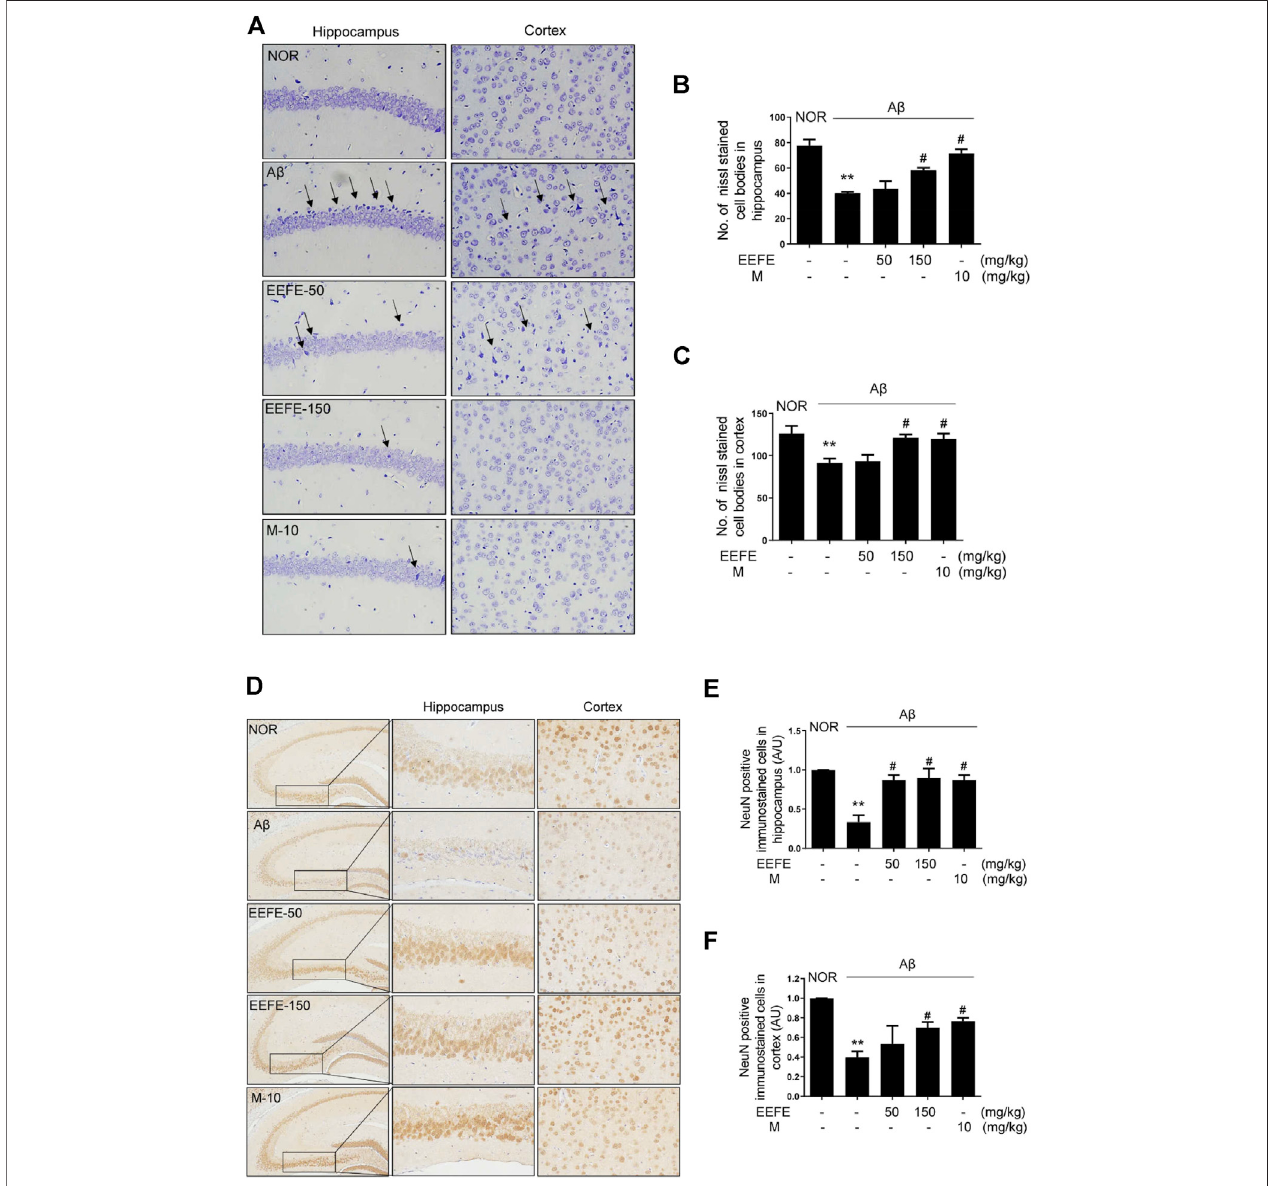
FIGURE 5 | Effects of EEFE on neuronal damage in A β -injected mice. Multiple 4- μ m paraf fi n sections of hippocampus and cortex regions were prepared from the sacri fi ced mouse brains. (A) Nissl staining was conducted using cresyl violet solution. (B, C) Graphs display the quantitative analysis of Nissl stained cell bodies in hippocampus (B) and cortex (C) .Black arrows indicate aneuronal shrinkage ofNissl body cells,karyopyknosis. (D) Theexpression ofNeuN,asaneuronal marker, was determined by immunohistochemistry. Square boxes indicate the magni fi ed neuronal degeneration in hippocampal area. (E, F) Graphs display the quantitative analysis of NeuN positive cells in hippocampus (E) and cortex (F) . Representative photomicrographs are shown at magni fi cation of × 400. The staining intensities are reported in arbitrary unit (AU). The data are presented as the mean ± SD ( n (cid:1) 3/group). ** p < 0.01 vs NOR group and # p < 0.05 vs A β group. A β , A β 1 – 42 – injected mice; EEFE, ethanol extracts of Ficus erecta ; M, morin; NOR: normal control mice.